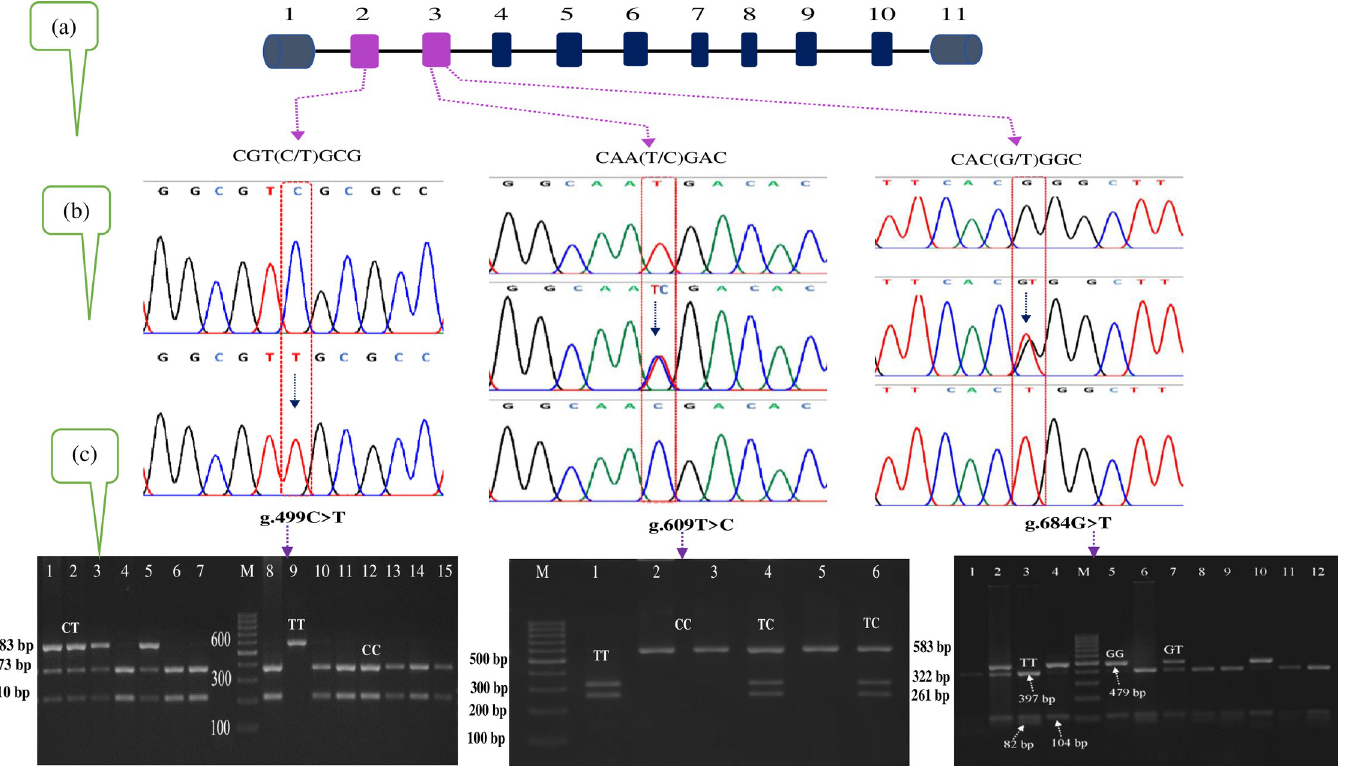
Fig 1. A schematic diagram of the present study to assess the MASP2 gene polymorphism in the Sahiwal. (a) Schematic representation of the MASP2 gene with the localization of the three identified SNPs. The blue gray, purple and dark blue bars represent exons, respectively; intervals represent introns. (b) DNA sequencing chromatogram of the polymorphic fragment. (c) PCR-restriction fragment length polymorphism (PCR-RFLP) genotyping of the amplified